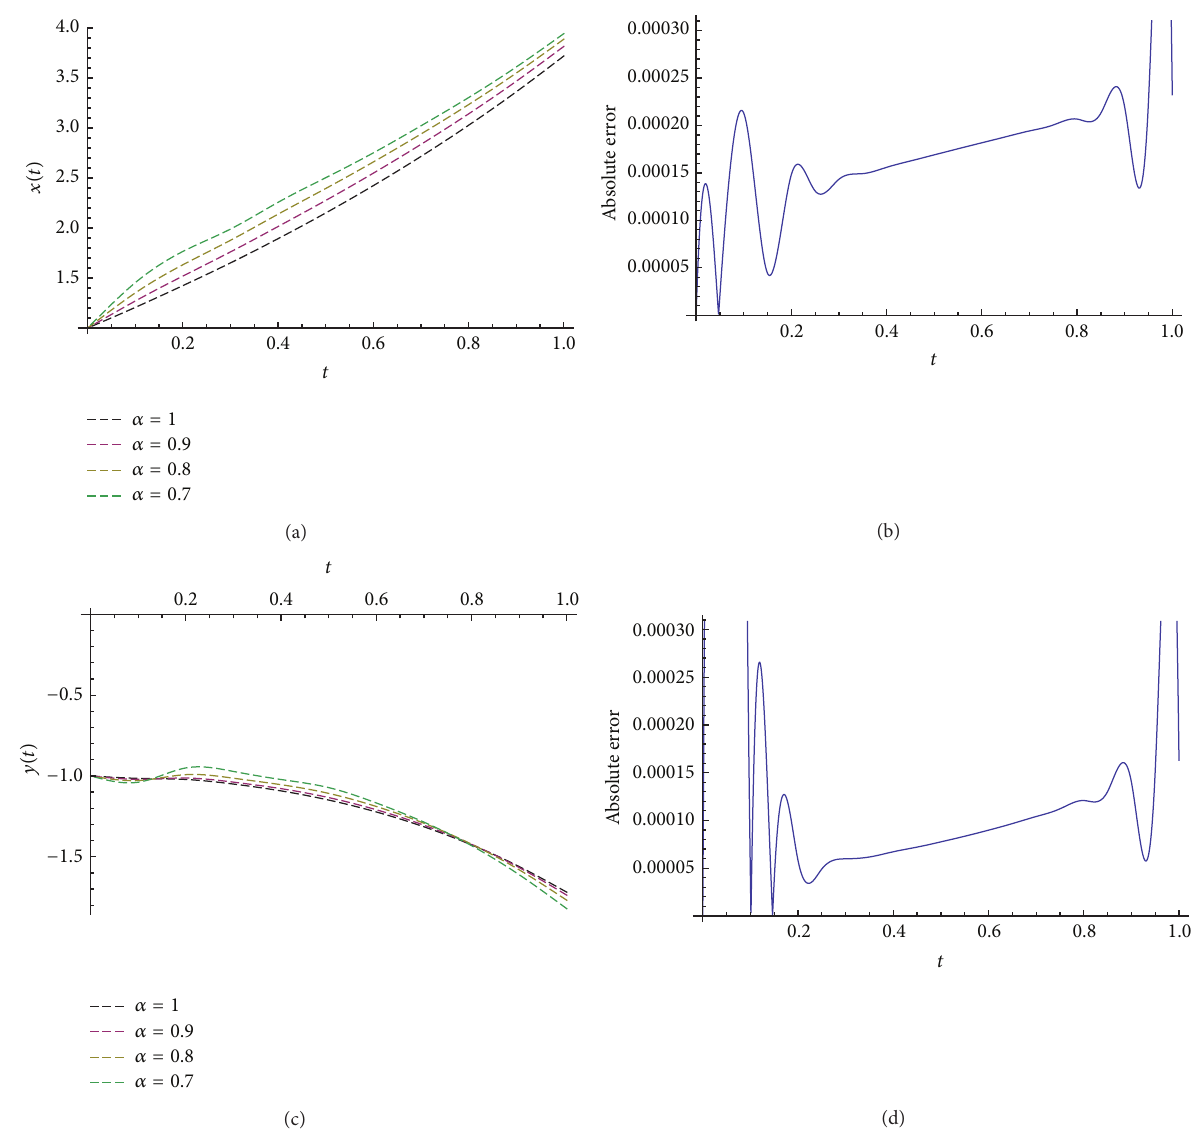
Figure 1: Graphical results for Example 1 when 𝛼 1 = 𝛼 2 = 𝛼 = 1, 0.9, 0.8 , and